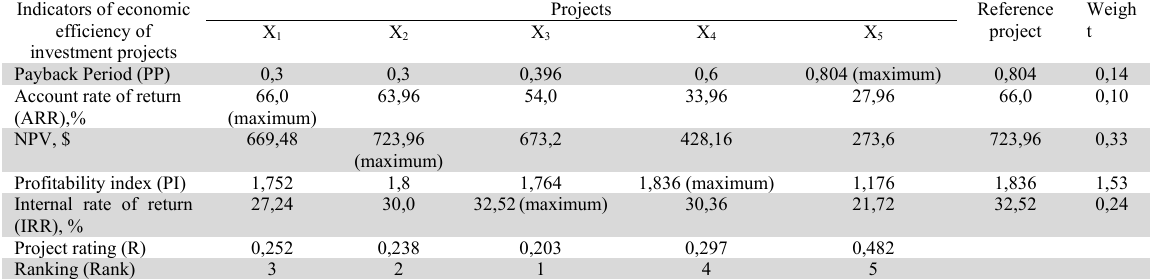
The results of choosing the best option for an investment project Indicators of economic efficiency of investment